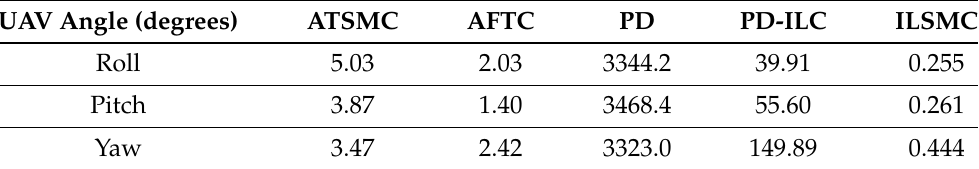
Figure 5. Performance in the presence of disturbances and uncertainties. Table 3. ITAE of UAV attitude control